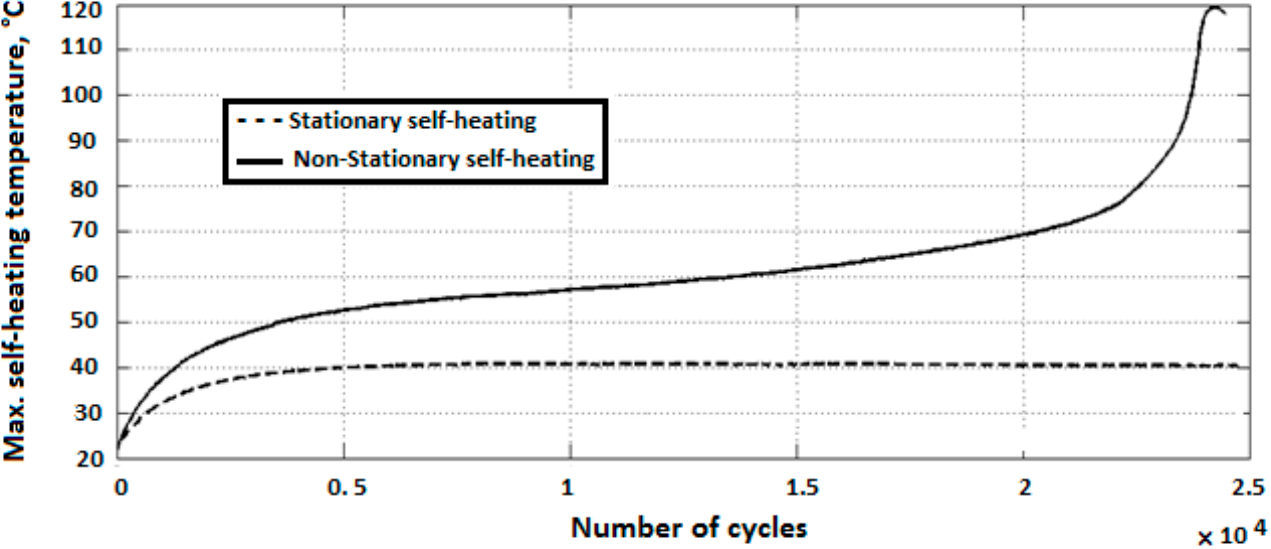
Figure 25. Exemplary self-heating temperature history curves for stationary and nonstationary self-heating scenarios, adapted with permission from Ref. [97]. Copyright © 2017 Elsevier